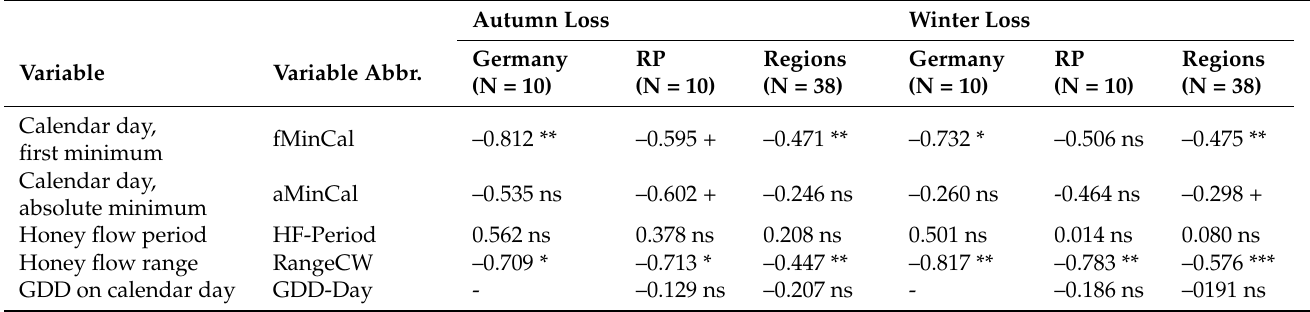
Figure 4. Annual colony loss rates in autumn and winter as a function of calendar day of first minimum cumulative weight (fMinCal) and range of cumulative weight (RangeCW) at three geographic levels of analysis: Germany ( A , D ); RP ( B , E ); administrative regions ( C , F ). Table 1. Correlation coefficients and significance levels of honey flow variables as predictors of autumn and winter colony loss rates. N = number of data points, GDD = growing degree days. For an explanation of geographic levels (Germany, RP, Regions), please refer to text. The number of observations are reported in Tables S2–S4.